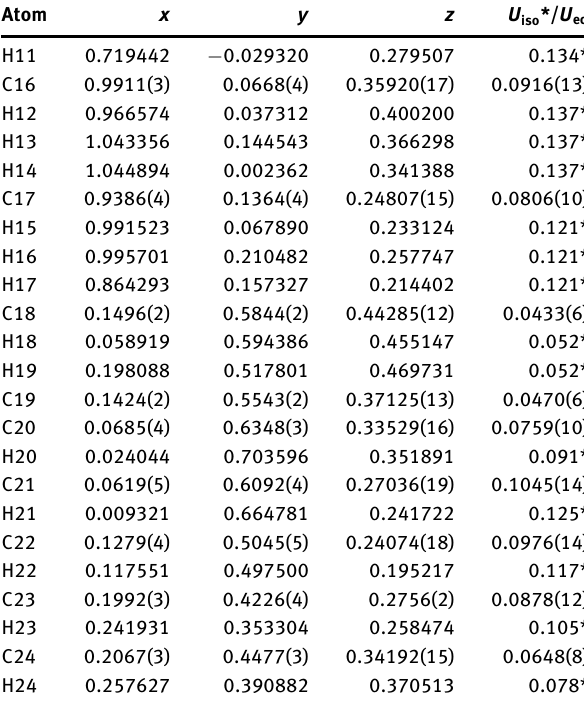
ium bromide as a yellow solid. Crystals of the title compound 2